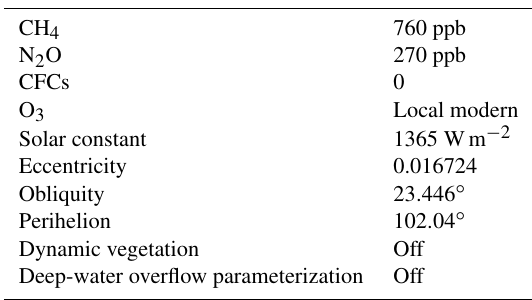
Table 1. Configuration common to all experiments described in this paper.